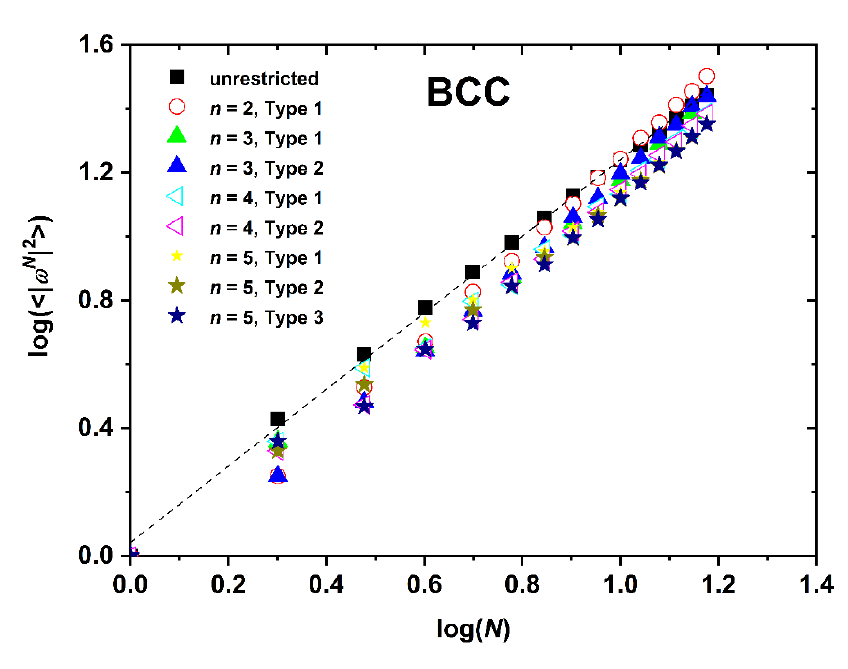
(cid:12) (cid:12) 2 (cid:105) (cid:12) (cid:12) , as a function of the (cid:12) ω N (cid:12)